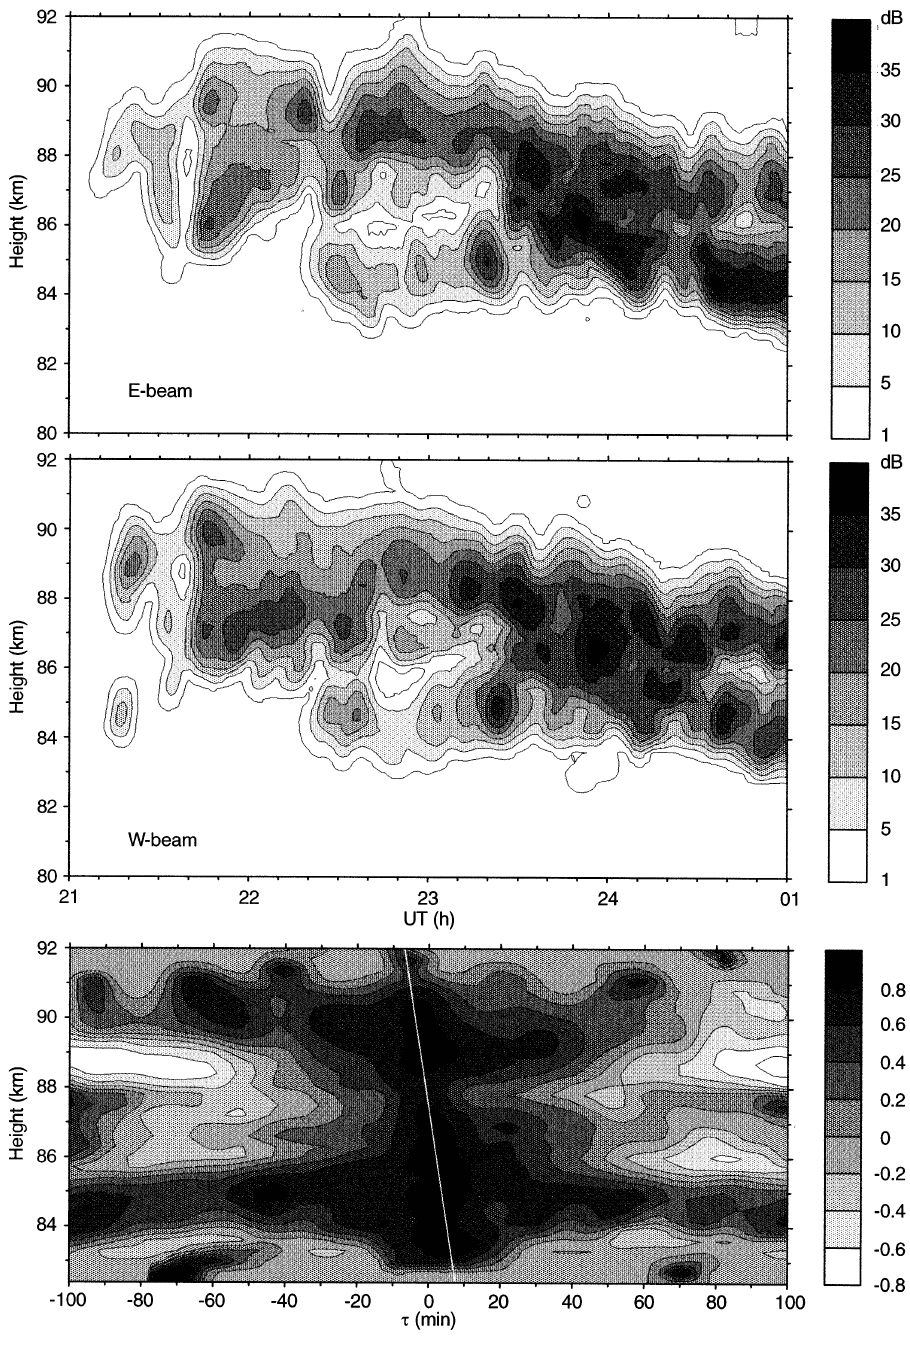
Fig. 13. PMSE event observed with the oblique E and W beams of the ALOMAR SOUSY radar on 28 — 29 July 1994 ( upper and middle part ) and cross- correlation function between SNR( t ) of the E beam and SNR( t # (cid:113) ) of the W beam as a function of height and time- delay (cid:113) ( lower part ). The white line approximately connects areas with maximum